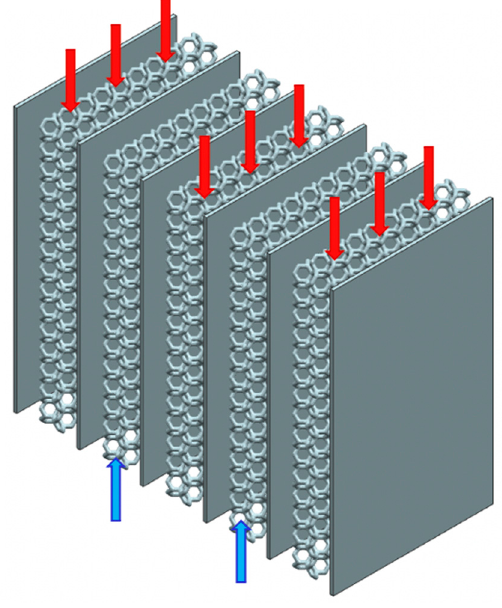
Figure 1. Schematic of the proposed compact gas-to-gas heat exchanger with engineered ceramic cellular architectures between the consecutive border plates.